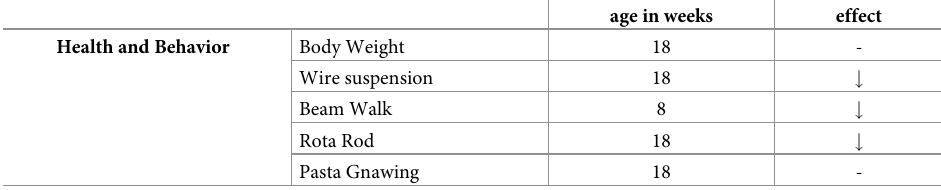
Table 2. Summary of health and behavioral changes in 4L/PS-NA mice compared to control animals.